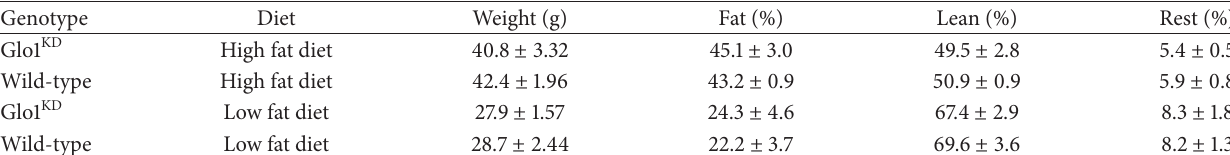
Table 1: The body composition was measured via Echo-MRI. There was no significant difference in the total body weight nor in the relative fat or lean mass ( 𝑝 ≥ 0.05 ).